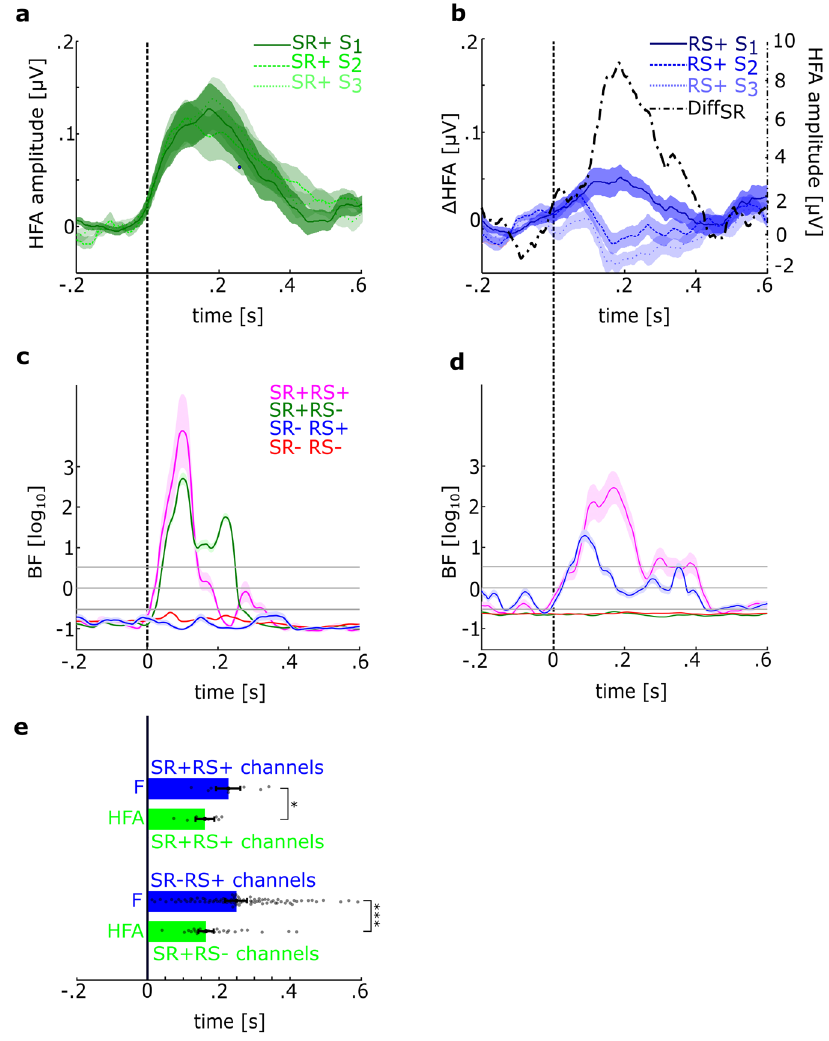
Fig. 2 Stimulus response and repetition suppression show different temporal pro fi les. a , b show the HFA amplitude modulation of SR + RS – ( a ) and SR – RS + ( b ) channels to S 1 , S 2 , and S 3 , the dashed black curve in b represents the summed sign of differences between S 1 & S 2 and S 2 & S 3 (Diff SR ). Positive values of this summed differences indicate a S 1 > S 2 > S 3 relationship, shaded areas represent the standard error of the mean. c , d show time-resolved BF for modulation of HFA over baseline (evidence for stimulus response) averaged separately across the four different channel sets (SR – RS + , SR + RS – , SR-RS-, and SR + RS + ) ( c ) and for the effect of repetition suppression averaged across channels, shaded areas represent the standard error of the mean ( d ). Only SR + RS – and SR + RS + channels show evidence for a stimulus response, only SR – RS + and SR + RS + channels show evidence for RS. The gray horizontal lines correspond to Bayes values 3, 1, and 0.3 with 3 and 0.3 denoting the critical levels for evidence for the alternate and null hypothesis, respectively. e shows peak latencies for RS ( F values, blue) and SR (HFA, green), compared within SR + RS + channels (upper bars) and between SR + RS – and SR – RS + channels (lower bars), error bars represent the standard error of the mean, gray dots represent single